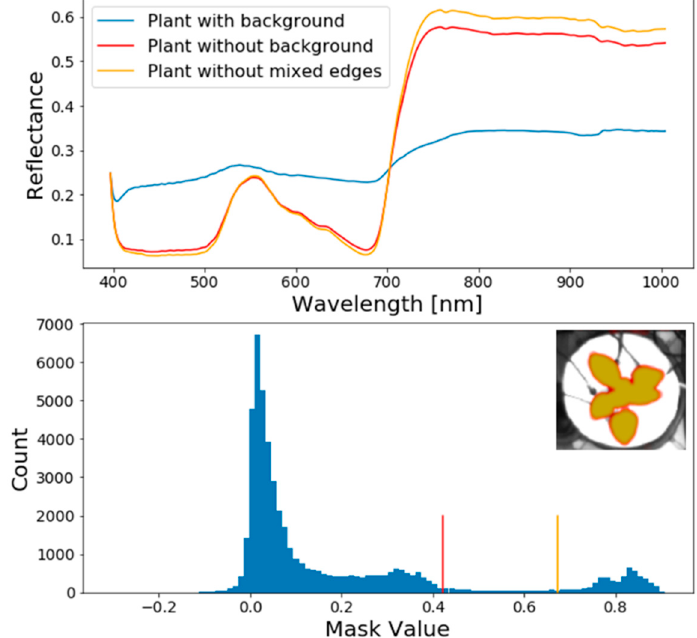
Figure 5. Top: mean spectrum of an exampled plant with its surrounding background (blue), mean spectrum without the background after running Otsu filter (red), mean spectrum of the plant without leaves edges after second Otsu filter run. Bottom: a histogram of the bounding box and the values calculated by Otsu filter.